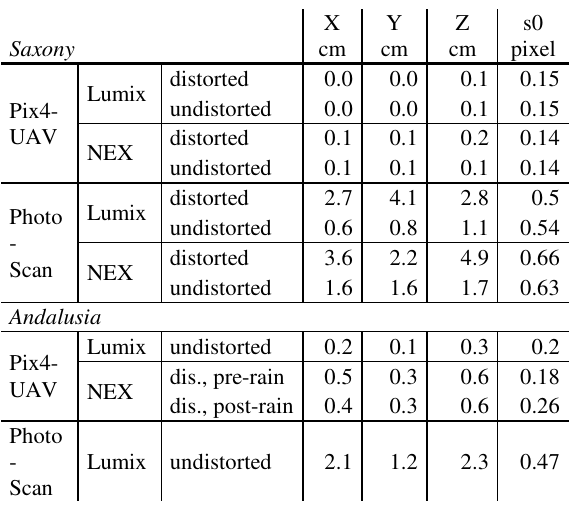
Table 3. Accuracy of image orientation, deviation of GCP coordinates (X,Y,Z) and mean reprojection error of bundle block adjustment (s0).